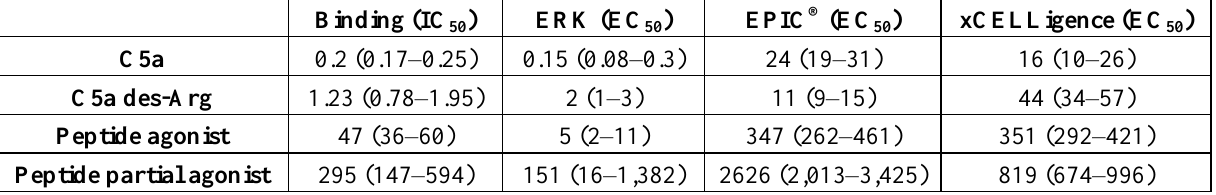
Table 2. Potency of ligands (nM) on CHO-C5aR cells across the different platforms tested. Binding assay performed using 25 pM 125 I-C5a. EC confidence intervals (n = 3 −